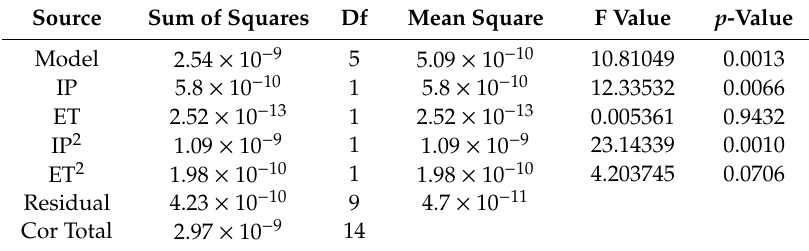
Table 5. Analysis of variance (ANOVA).